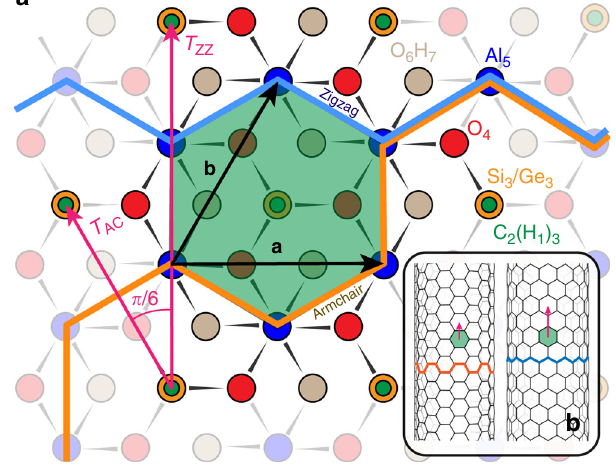
Fig. 1 Imogolite unit cell. a Hexagonal unit cell of the imogolite nanotube or of its methylated analog. The color of each circle corresponds to a scattering center: green for inner OH (CH 3 ), gray for outer OH, blue for Al, red for O, and orange for Si/Ge. ( a , b ) is a lattice basis. The index refers to the radial atomic labeling introduced by Alvarez-Ramírez 47 and adapted by Poli et al. 34 . It corresponds to the sequence of atoms encountered on passing from the inner to the outer surface of the tube. The inset ( b ) displays an armchair and a zig-zag nanotube. Terms ‘ armchair ’ and ‘ zig-zag ’ are used in analogy with SWCNTs and illustrated by the orange and blue ‘ armchair ’ and ‘ zig-zag ’ lines drawn in Fig. 1 and in the inset. The periods of armchair and zigazg nanotubes, noted T AC and T ZZ , are drawn with purple